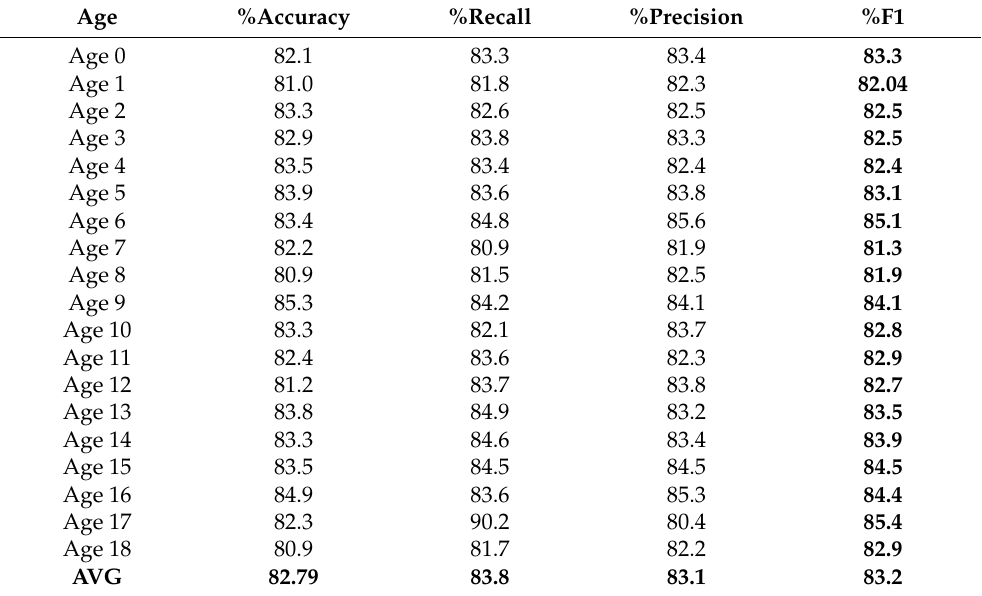
Table 5. Evaluation of the proposed system’s performance for different age groups by accuracy, precision, recall, and